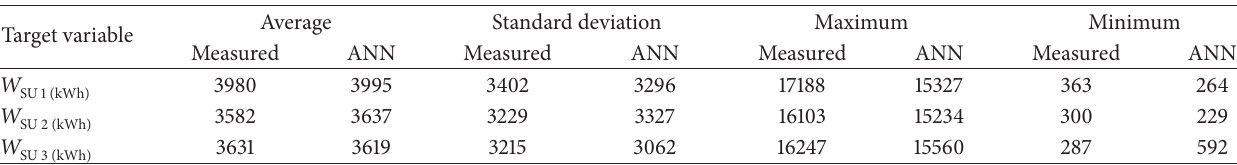
Table 9: Descriptive statistics of the measured MES time series and the time series modeled by the best artificial neural network ANN calculated over all available daily